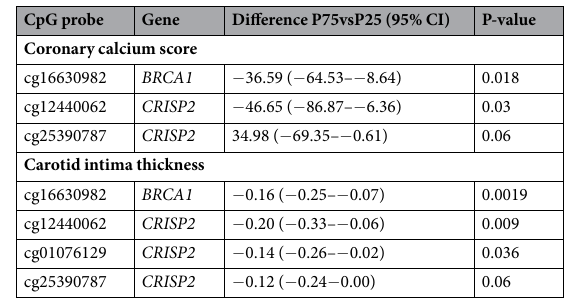
Table 2. Significant associations of BRCA1 and CRISP2 CpG probes with coronary calcium score and carotid intima